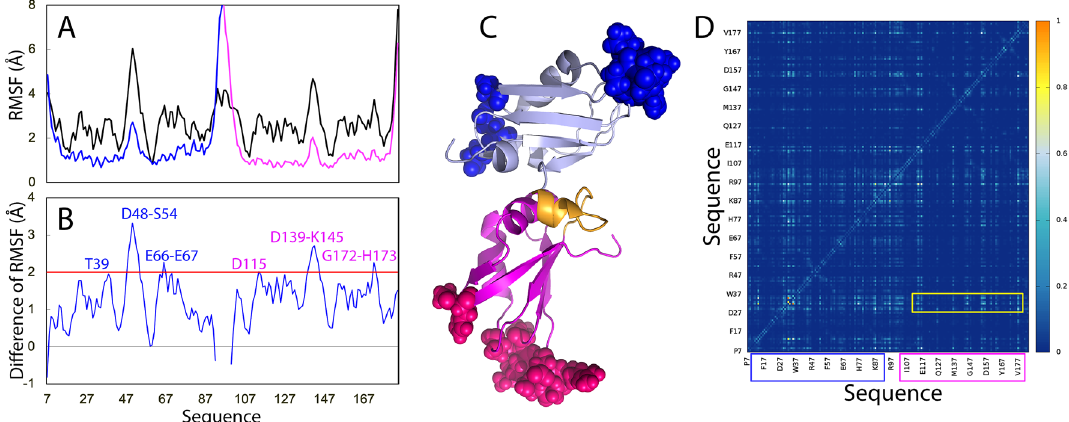
Figure 9. Residue-specific dynamic behaviors of the hnRNPA1 RRM domains. ( A ) Averaged root-mean- square fluctuations (RMSF) of the Cα atoms computed over three independent MD simulations for the tethered RRM1–RRM2 (black), as well as isolated RRM1 (blue) and RRM2 (pink). ( B ) The difference of the average RMSF between the tethered RRM1–RRM2, and isolated RRM1/RRM2. The residues are labeled for those with significant difference of RMSF (> 2.0; average + one STD). ( C ) Structure of the hnRNPA1 RRM1–RRM2 with the residues displayed in spheres which show significant difference of RMSF between the tethered and isolated states. The image was prepared by PyMol2.4 (https ://pymol .org). ( D ) Mutual information matrix calculated from three parallel MD simulation data of the tethered hnRNPA1 RRM1–RRM2 by MutInf, with residues having significant inter-domain correlation motions highlighted by yellow box. The RRM1 sequence is indicated by blue box and RRM2 sequence in pink